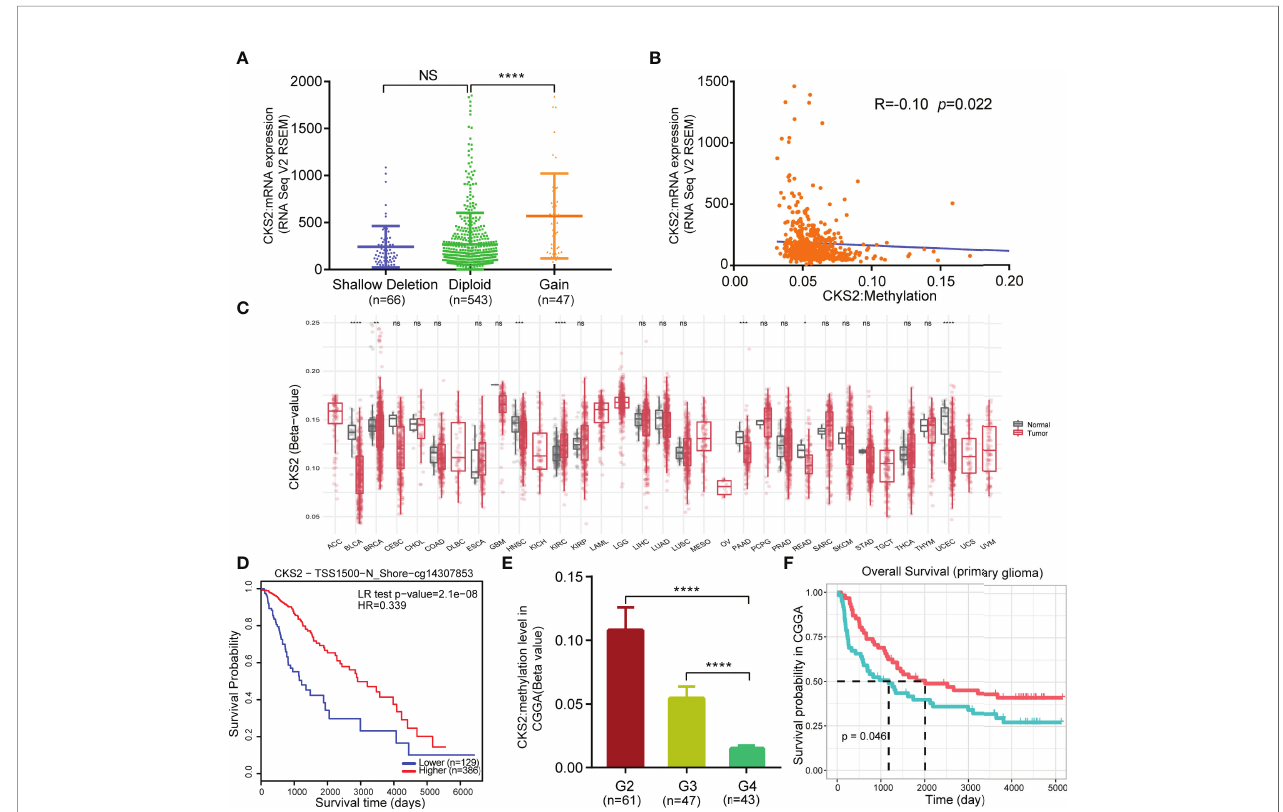
FIGURE 6 | Copy number variation (CNV) and methylation expression of CKS2 in glioma. (A) Changes in CKS2 expression levels under different copy numbers (n = 656). (B) Correlation between CKS2 methylation level and expression (n = 530). (C) Methylation expression levels of CKS2 in various tumor tissues and normal tissues in TCGA data. (D) Kaplan – Meier survival of the promoter methylation of CKS2 in glioma (n = 515). (E) Association between WHO-de fi ned glioma grade and CKS2 methylation levels in data from the CGGA (n = 151). (F) Overall survival curves grouped based on CKS2 methylation levels (n = 123). * p < 0.05, ** p < 0.01, *** p < 0.001, and **** p < 0.0001. NS, not signi fi